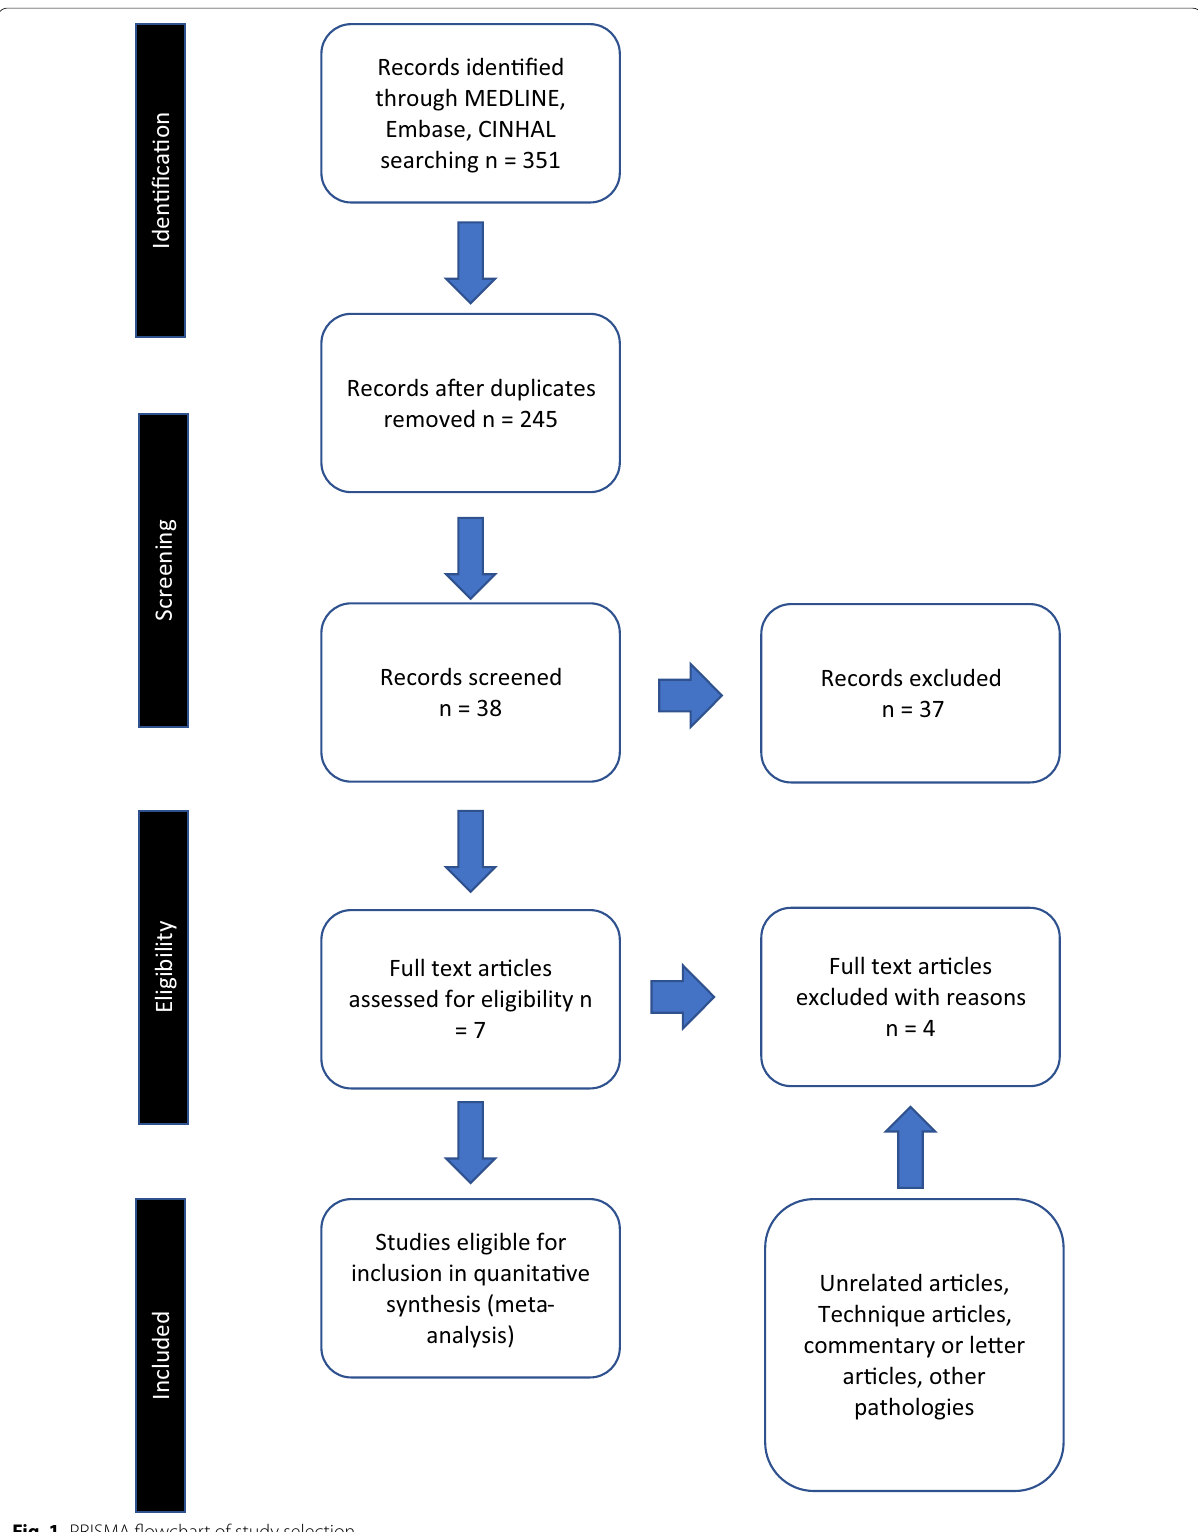
Fig. 1 PRISMA flowchart of study